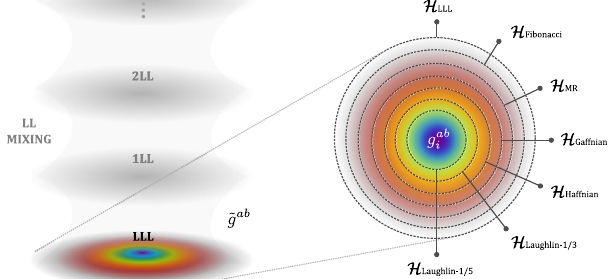
Fig.1|IntrinsicmetricsinFQHstates. Theleftpanelshowsthatthe fl uctuationsof the cyclotron metric ~ g ab originate from the LL mixing. The right panel shows the hierarchicalstructureoftheCHSs(denotedbydashedcircleswithdifferentcolors) ofthecorrespondingmodelHamiltonians(moredetailscanbefoundinTable2)in the lowest Landau level. Each of these spaces can have its own metric g ab i , the fl uctuation around which can potentially lead to multiple GMs in a single Landau level.